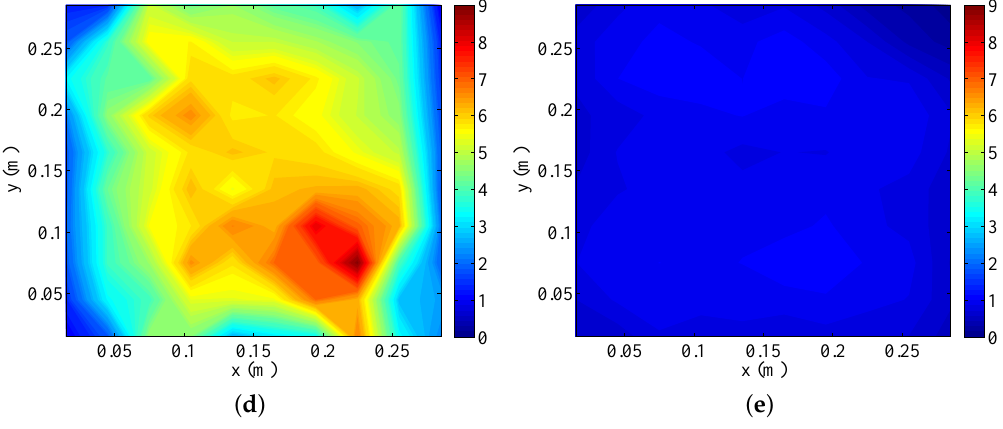
Figure 8. The map of sensor energy consumption. ( a ) Multi-hop network. ( b ) DaaG